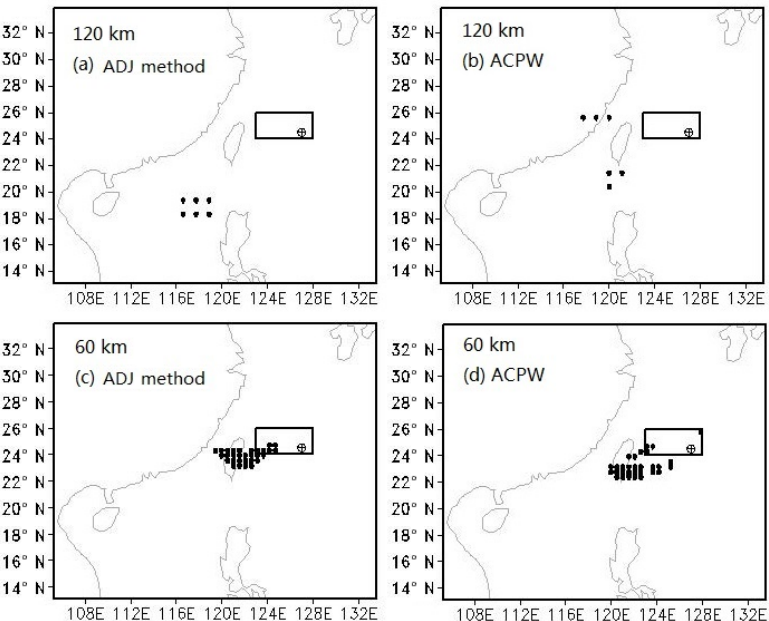
Figure 13. Sensitive regions identified by the CNOPs with 6 points at the 120km resolution and 30 points at the 60km resolution for TC Fitow. The squares indicate the verification areas, and the initial cyclone positions are shown as ⊕ . The letters (a) and (b) denote the CNOP patterns at the 120km resolution for the ADJ method and the ACPW algorithm, respectively, while letters (c) and (d) represent the CNOP patterns at the 60km resolution for the ADJ method and the ACPW algorithm, respectively.